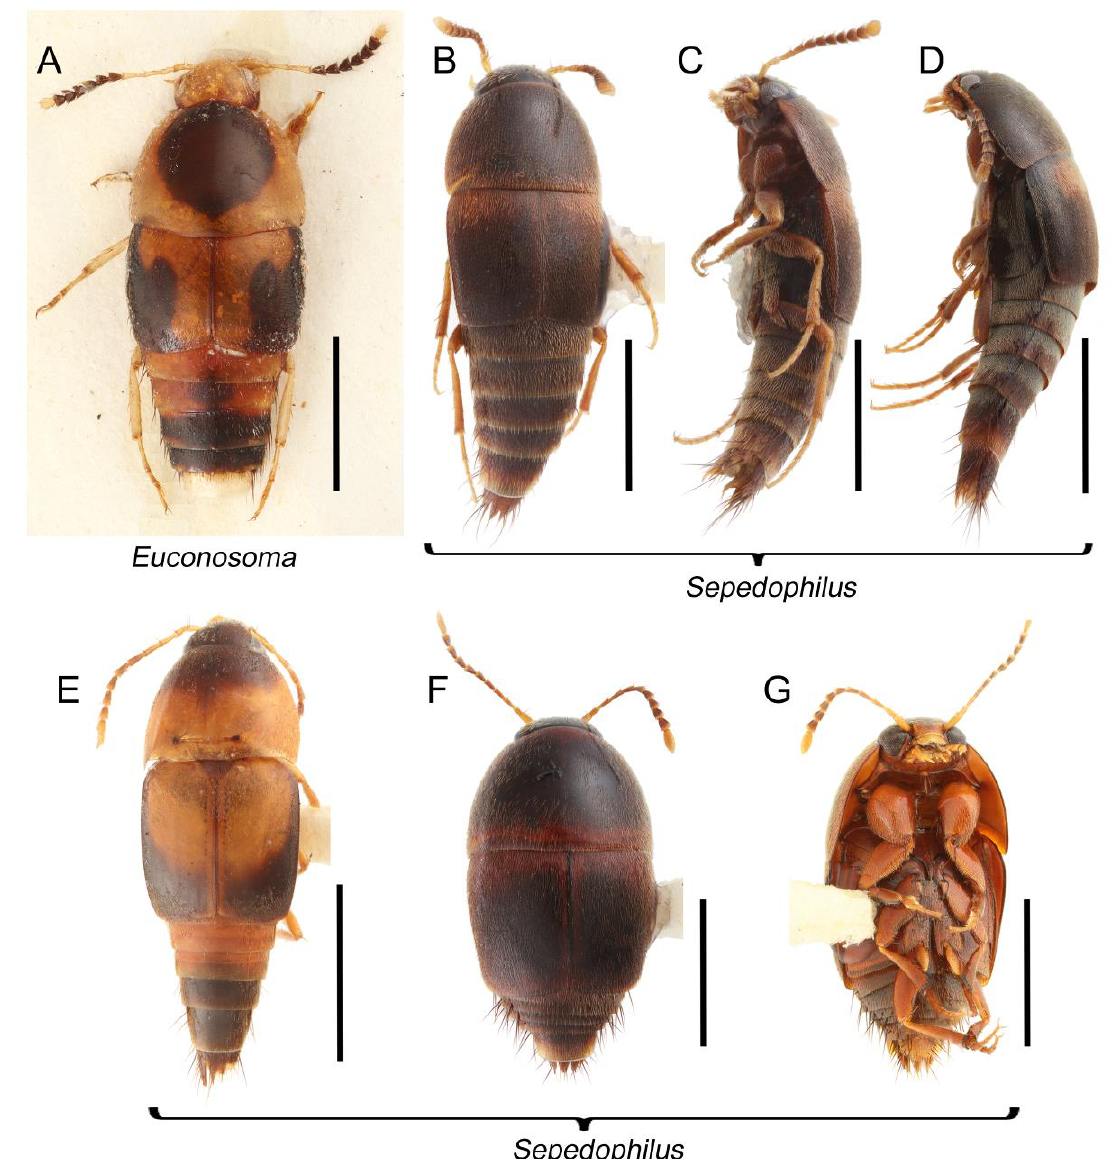
Figure 14. Habitus photographs of Tachyporini: Euconosomatina. ( A ) Euconosoma picta (Bernhauer), dorsal view. ( B ) Sepedophilus cinctulus (Erichson), dorsal view. ( C ) Sepedophilus cinctulus (Erichson), ventrolateral view. ( D ) Sepedophilus bisignatus (Horn), dorsolateral view. ( E ) Sepedophilus littoreus (Linnaeus), dorsal view. ( F ) Sepedophilus crassus (Gravenhorst), dorsal view. ( G ) Sepedophilus crassus , ventral view. Scale bars: 2.0 mm ( A ); 1.0 mm ( B , C ); 1.5 mm ( D – G